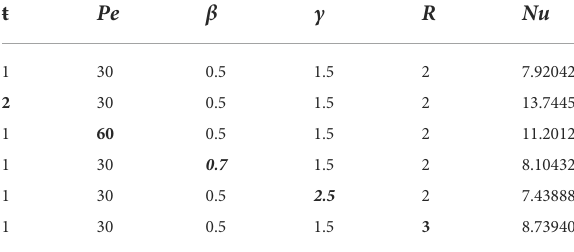
The bold-italic values shows the increasing values of the parameters. TABLE 6 The behaviour of the Sherwood number with the variation of parameters on the right plate.